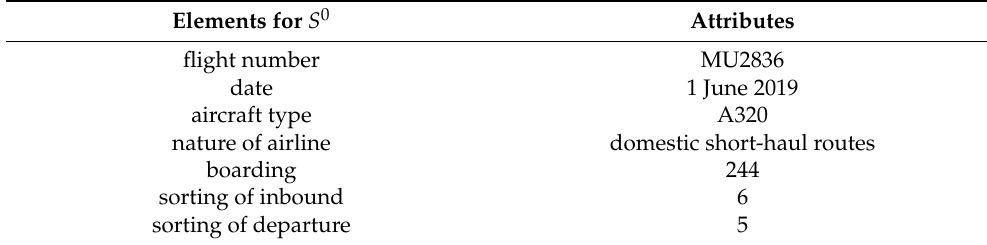
Table 2. Sample of ground handling process attributes, where 15 min is the unit time for sorting of prologue and backorder.